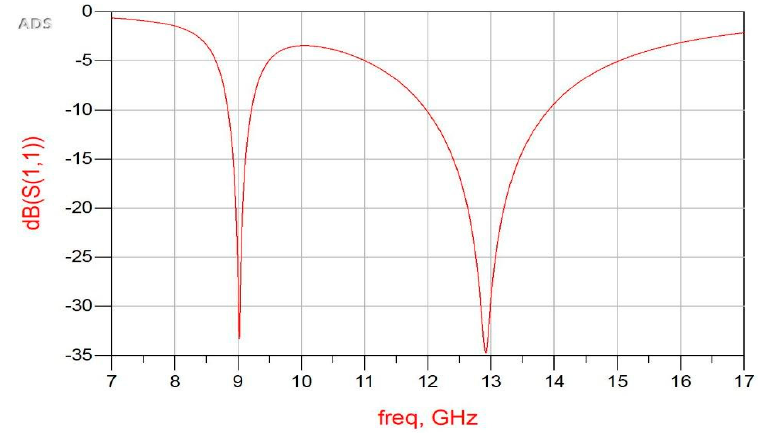
Figure 9. Simulated result using ADS Agilent equivalent circuit .